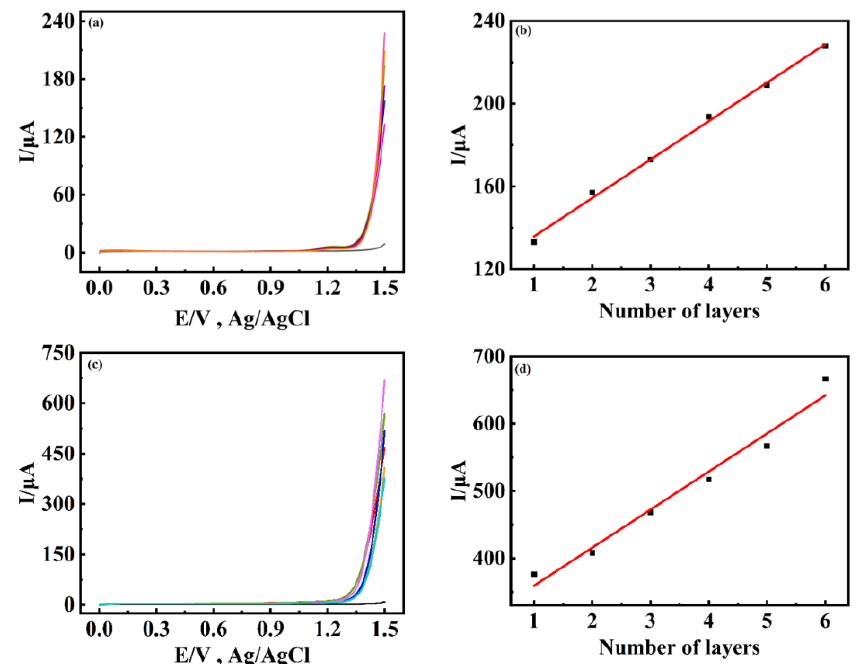
Figure 7. The electrocatalytic water oxidation curves of two composite films [PDDA/Ni25] n ( n = 1 − 6) ( a ), and PDDA/[Ni25/(PDDA − rGO)] n ( n = 1 − 6) ( c ), deposited on ITO in 1 M NaAc + HAc at pH 6. Scan rate: 50 mV s − 1 . The black curve represents the electrocatalytic water oxidation curve of bare ITO electrode. The relationship between the currents and the layer numbers at 1.5 V for [PDDA/Ni25] n ( b ), and PDDA/[Ni25/(PDDA − rGO)] n ( d ).